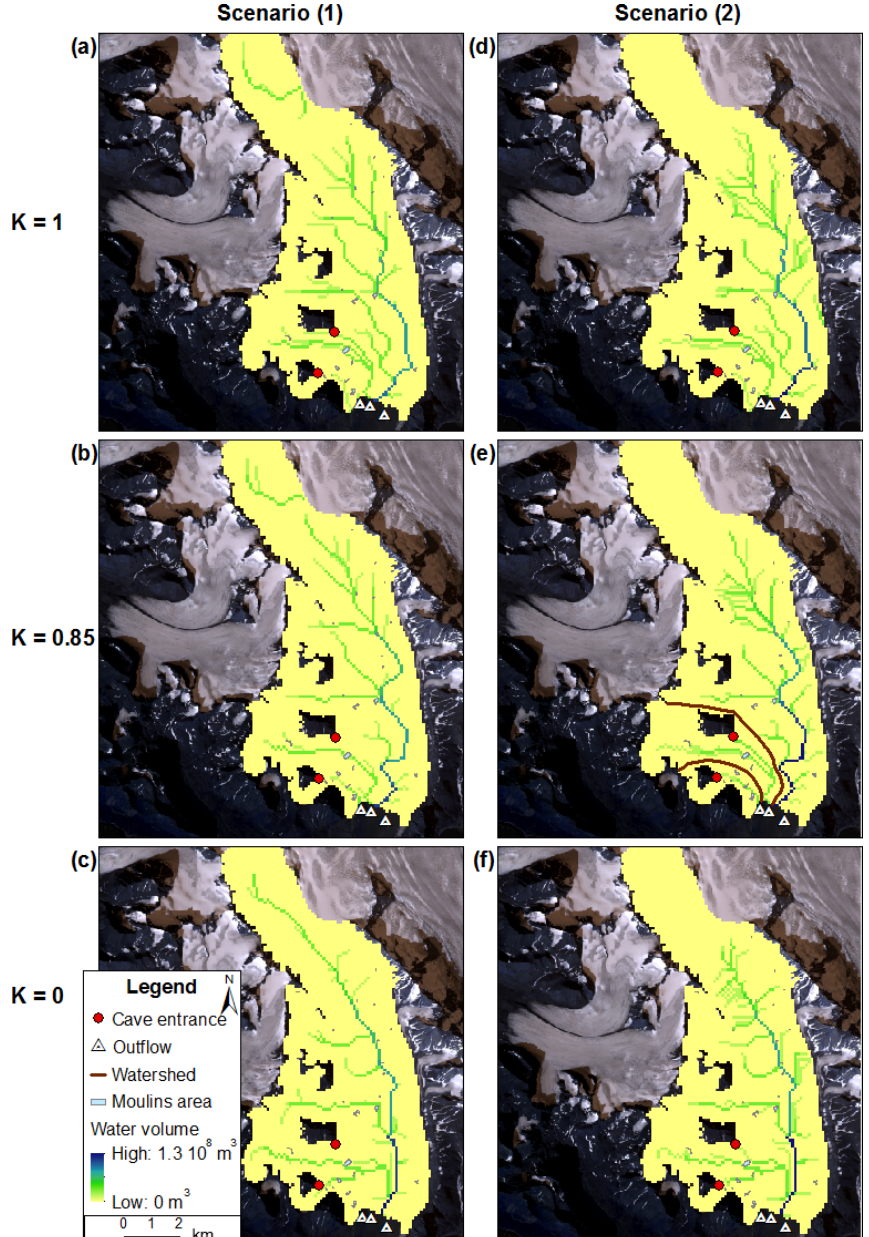
Figure 6. Map of the theoretical pattern of subglacial channels of Hansbreen modeled with scenarios (1) – K = 1 (a) , K = 0 . 85 (b) , K = 0 (c) – and (2) – K = 1 (d) , K = 0 . 85 (e) , K = 0 (f) . The map background is a WorldView-2 VHRS image acquired on 21 August